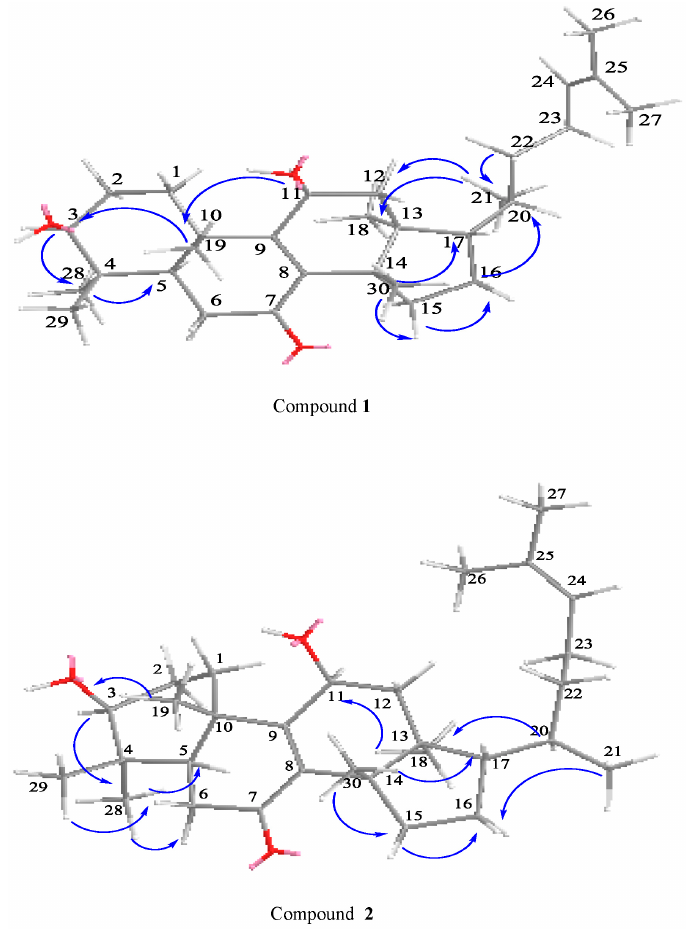
Figure 2. Key NOESY correlations for 1 and 2 .